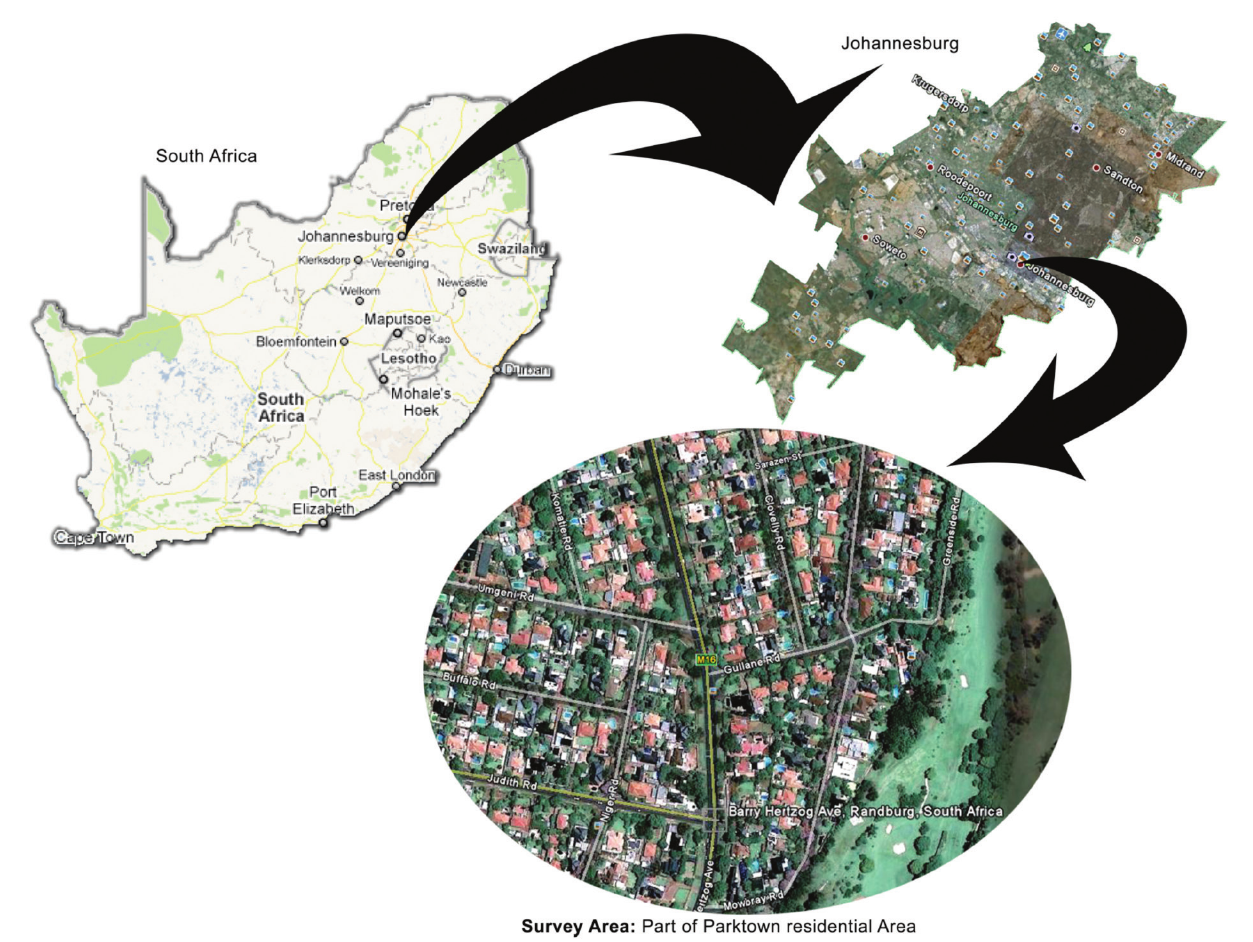
Figure 1: Macro and micro location of study area Source: Google